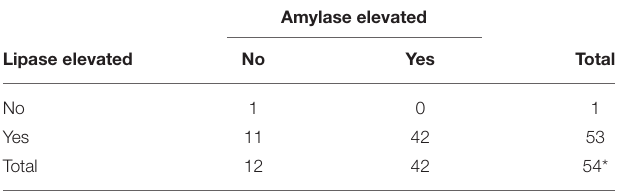
TABLE 3 | Contingency table of lipase and amylase.